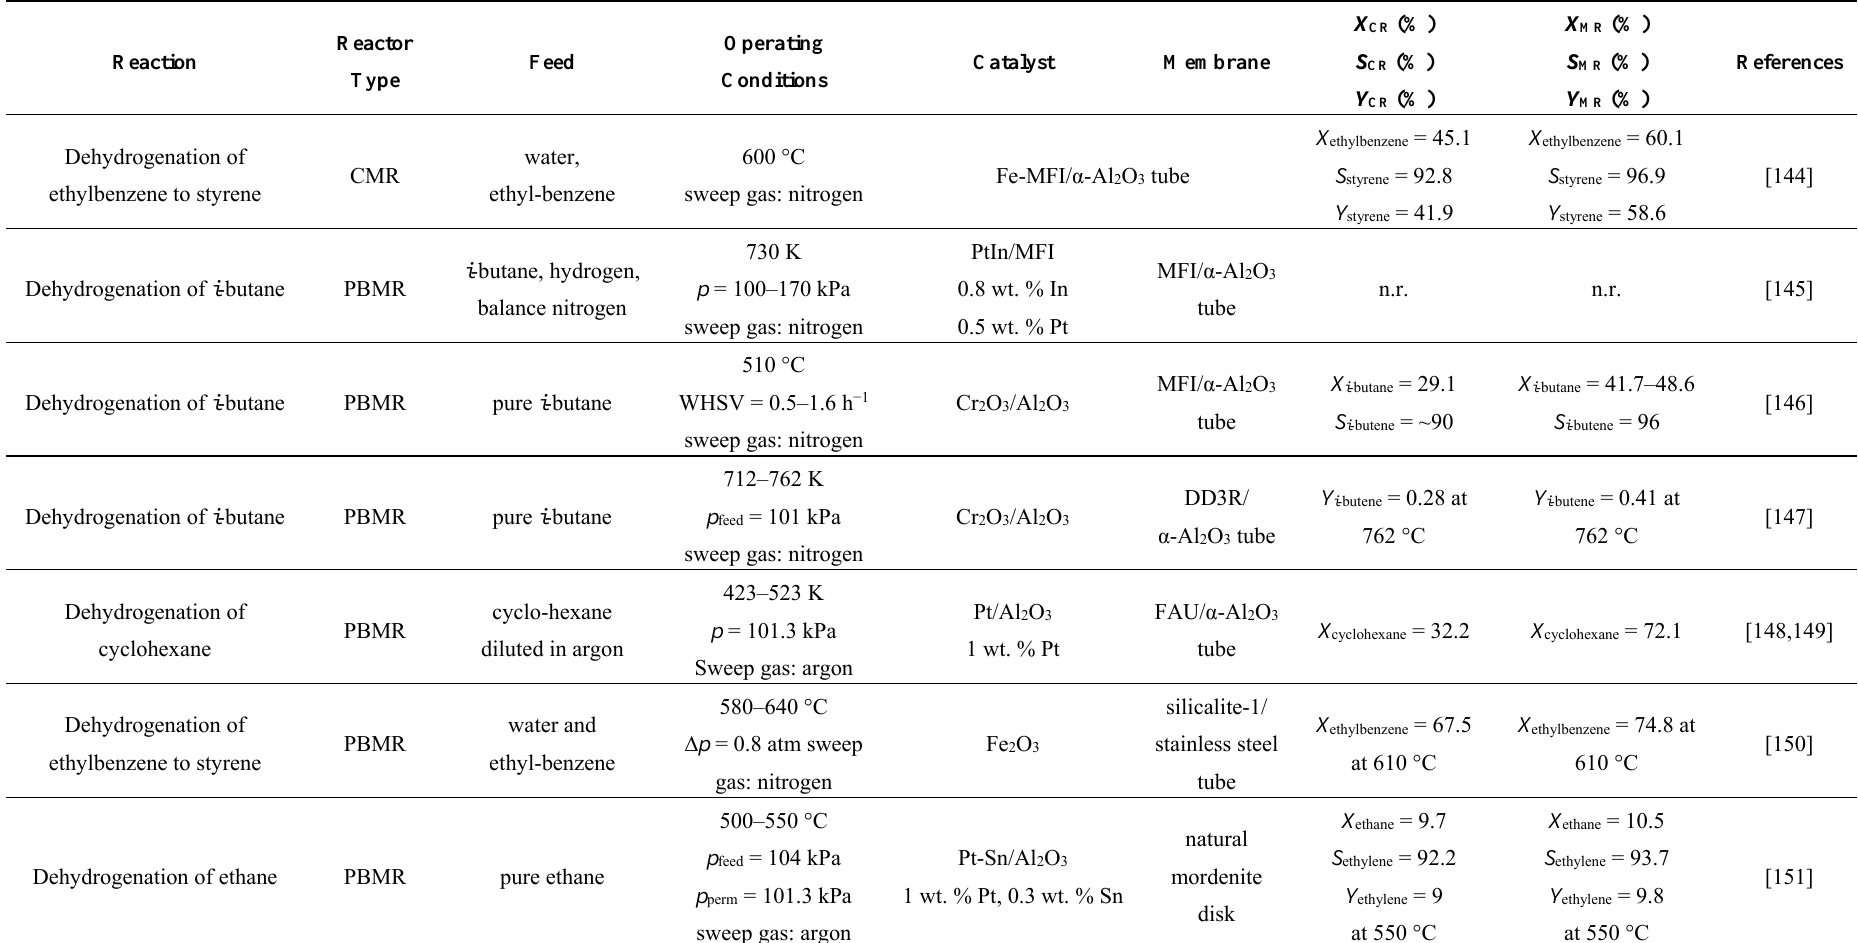
Table 1. Overview of the application of permselective inert or catalytic active zeolite membranes in membrane reactor configurations for different processes reported in the